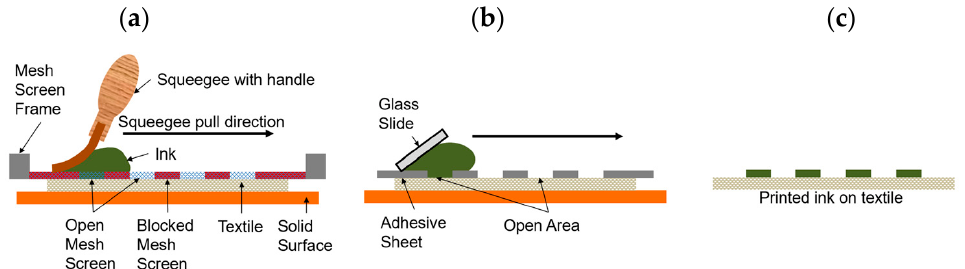
Figure 1. ( a ) Graphical representation of typical textile screen-printing; ( b ) graphical representation of screen-printing process used in this work, which replaces the mesh screen with a laser cut adhesive sheet; and ( c ) finished product of both processes.